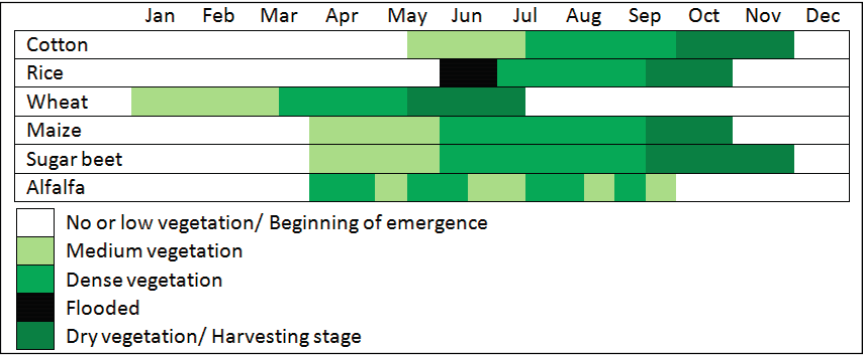
Figure 1. Idealized cropping calendar of the main crop types grown in the study